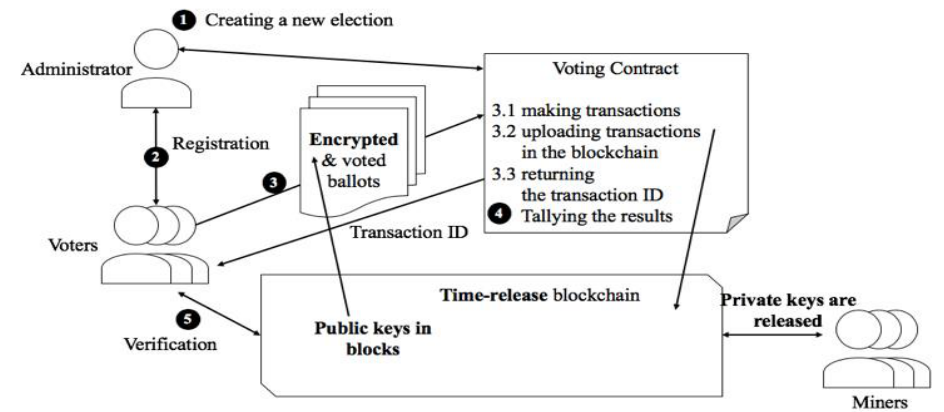
Figure 14. Proposed e-voting procedure that is based on the time-release blockchain [17].